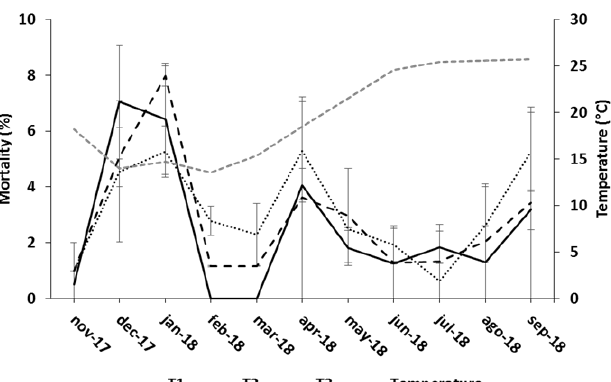
Figure 1. Reported monthly mortality (mean ± standard error) in the different feeding treatments, and water temperature during the trial.